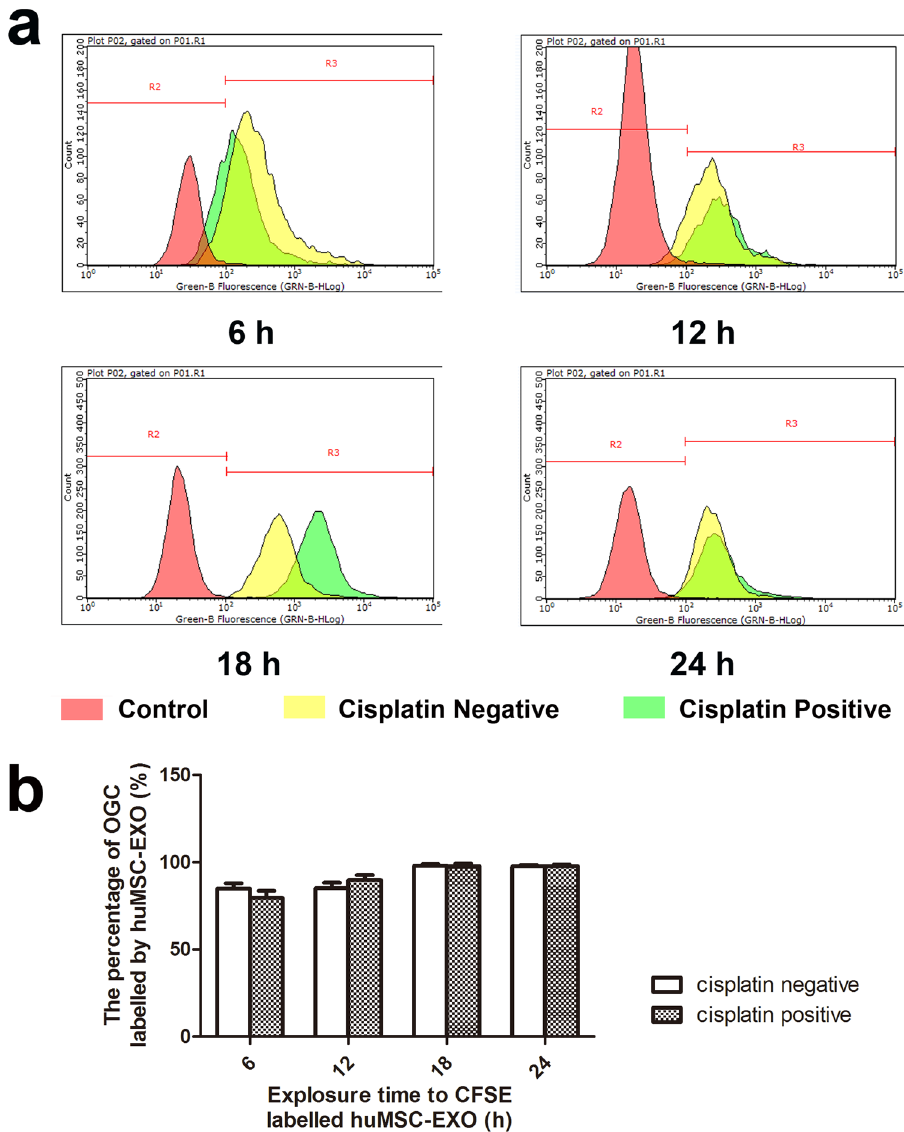
85.19 ± 5.37%, 98.06 ± 1.48% and 97.67 ± 1.51% at 6 h, 12 h, 18 h and 24 h, respectively, whilst the percentage was 79.56 ± 7.00%, 89.83 ± 4.73%, 97.81 ± 2.49% and 97.68 ± 1.89%, respectively, in the cisplatin-positive group. The results showed that huMSC-EXOs were effectively taken up by OGCs, and the uptake ratio was not different in the presence of 4 µ g/ml cisplatin (P < 0.05); n =